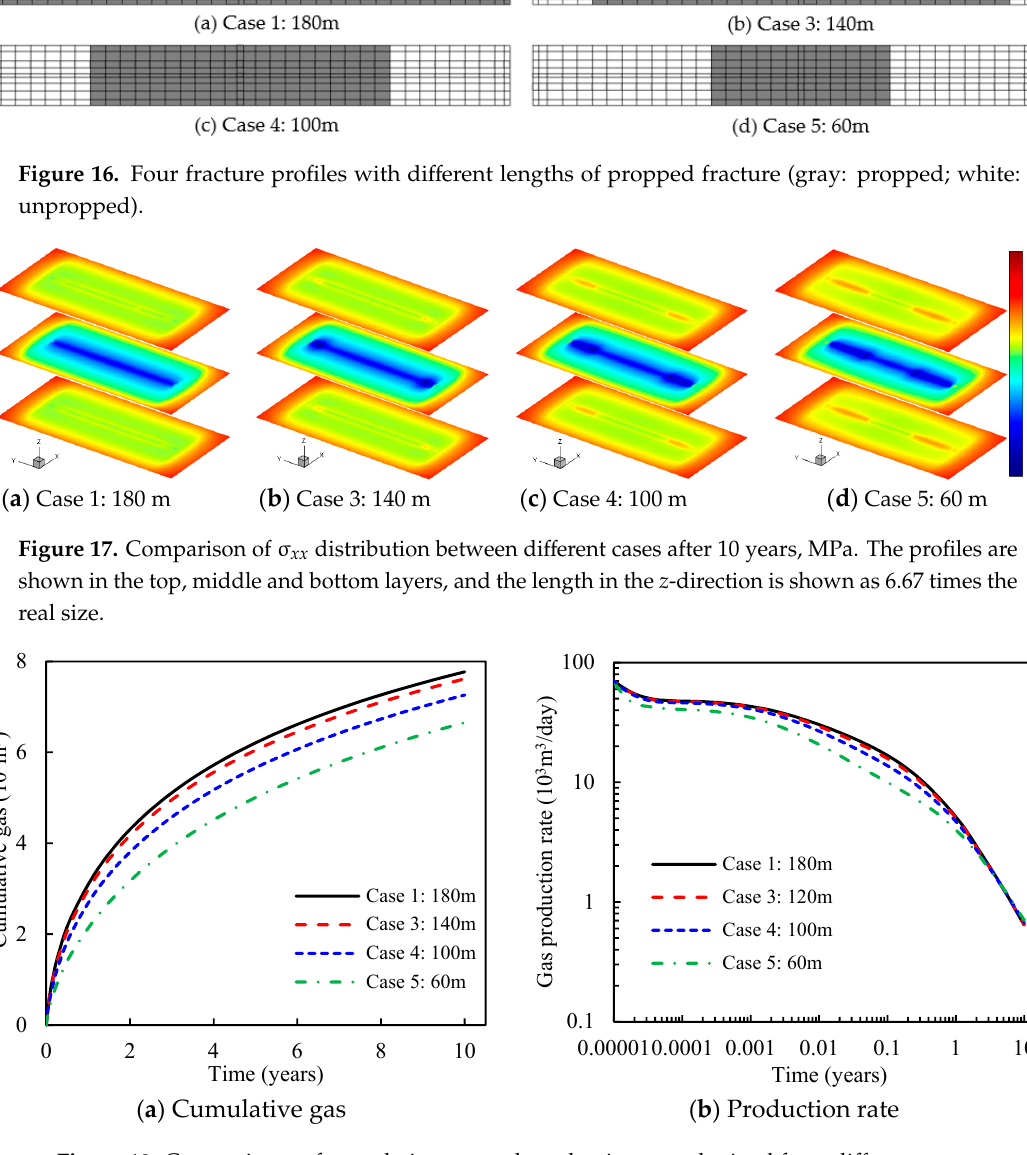
Figure 18. Comparisons of cumulative gas and production rate obtained from different cases.